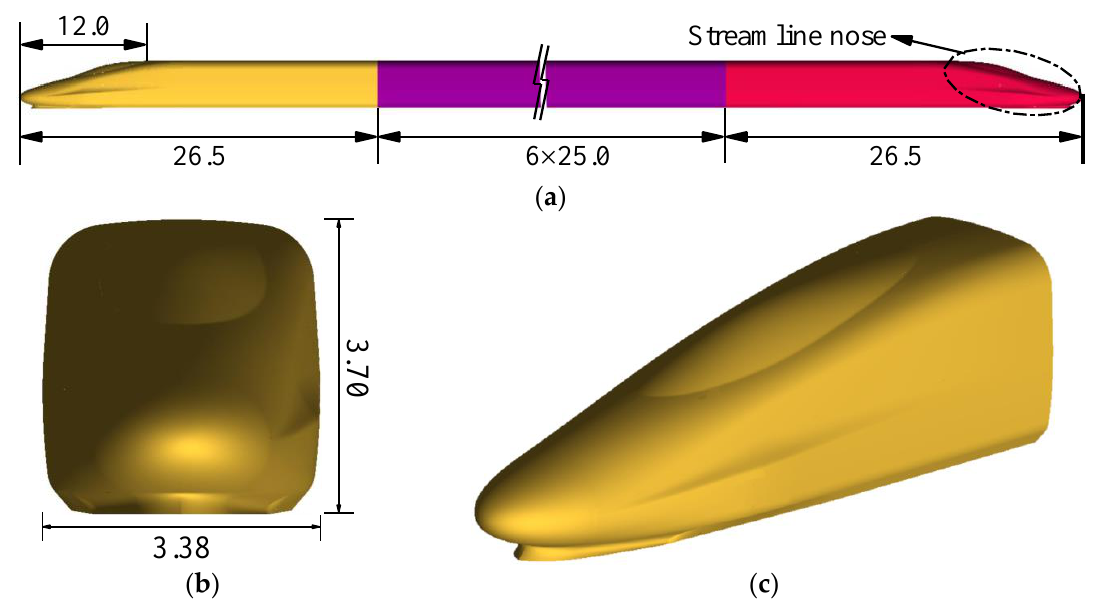
Figure 2. Train model (unit: m). ( a ) Side view; ( b ) Front view; ( c ) Streamline nose.